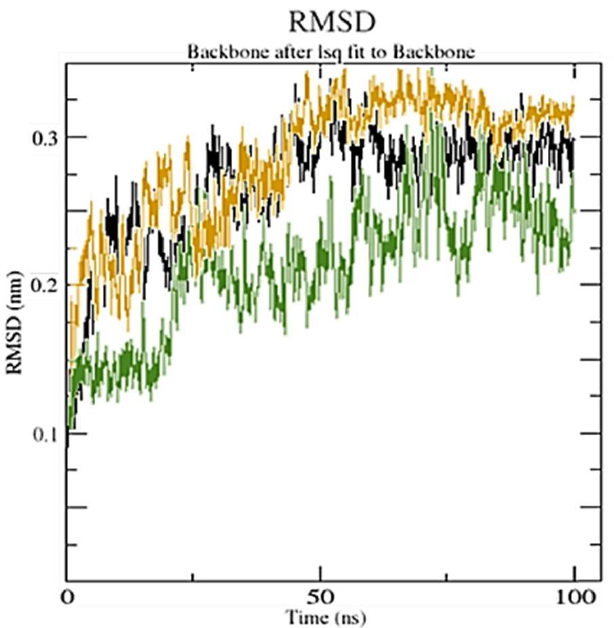
Figure 6. The RMSD over 100 ns. The black color represents serotonin receptor alone, orange color represents the BarS complex, and green color represents the BarCS complex.